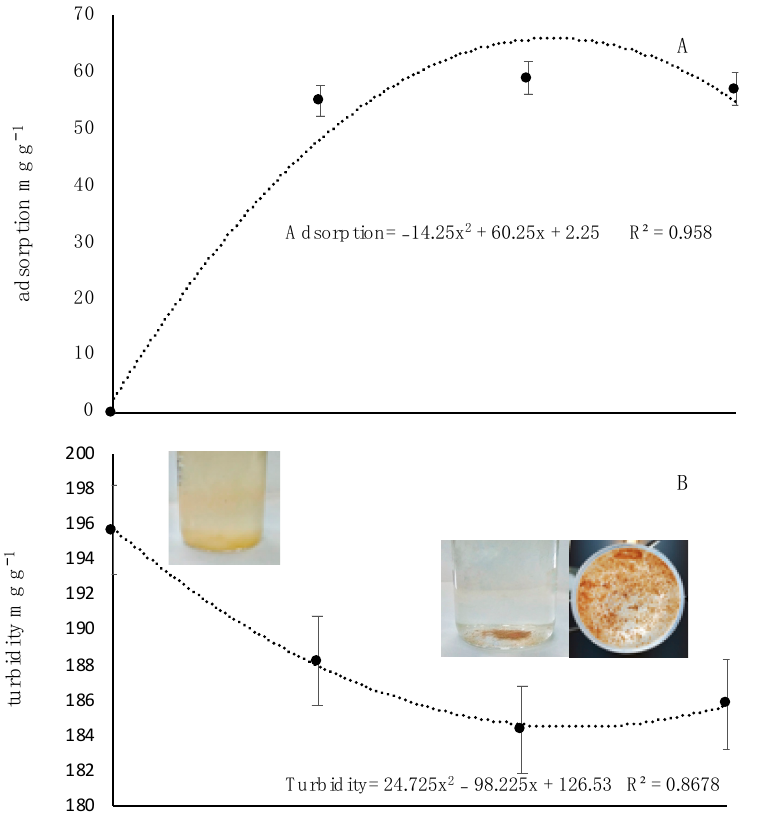
Figure 2. Particles adsorption ( A ) and turbidity ( B ) from water treated with Nopalea cochenillifera biomass.